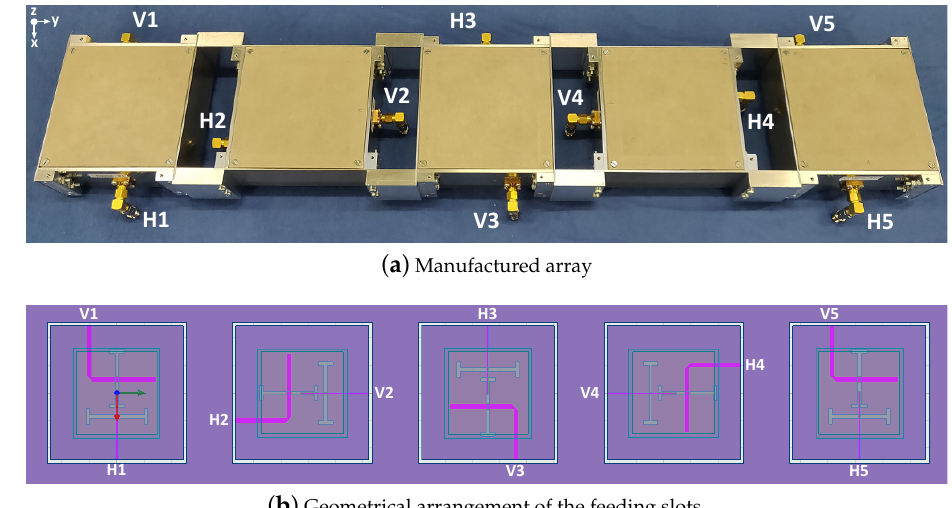
Figure 14. Sequential 90° rotation of the antenna